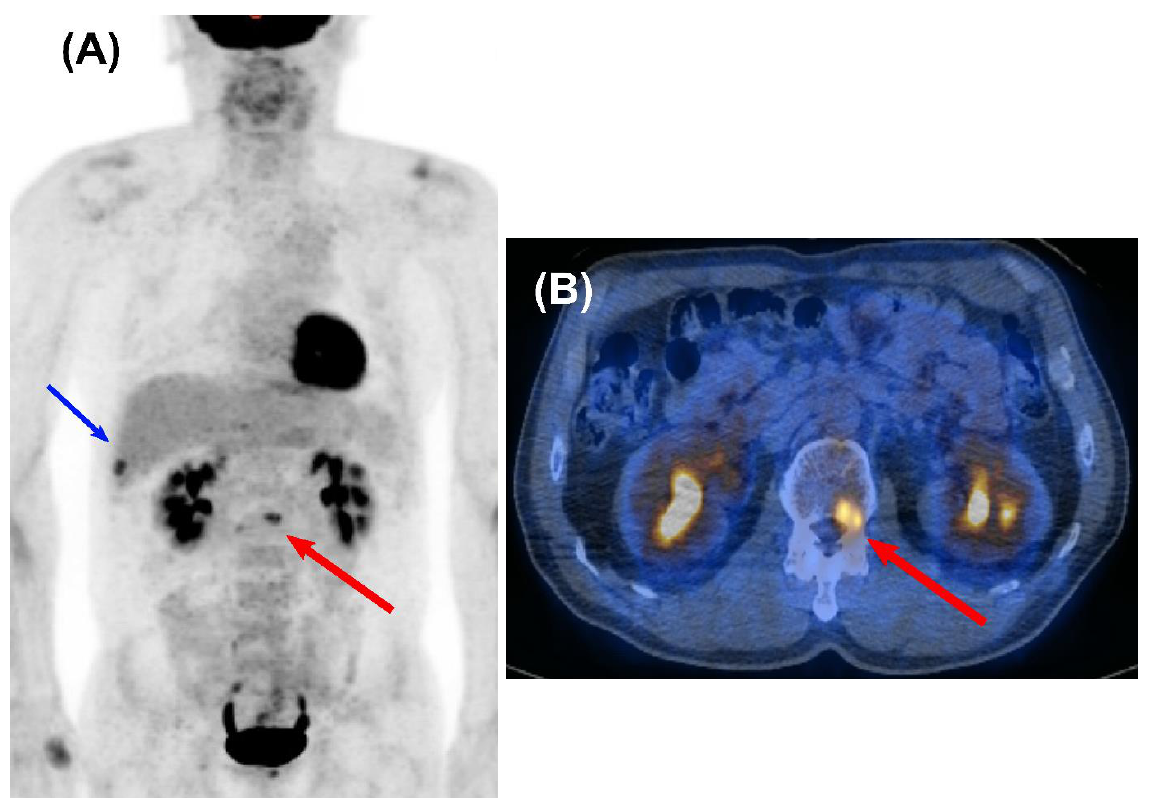
Figure 2. Oligometastasis detected by surveillance FDG PET/CT in a 58-year-old male who under- went curative surgery for NSCLC. A maximum intensity projection (MIP) ( A ) and a transaxial fused PET/CT image ( B ) obtained at 16 months after curative resection showed focal FDG uptake on the L2 spine, indicating metastasis to the bone (red arrow). He survived for 70 months after localized radiotherapy with palliative chemotherapy. Another focal FDG uptake on the right lower thorax indicates recent post-traumatic change (blue arrow).